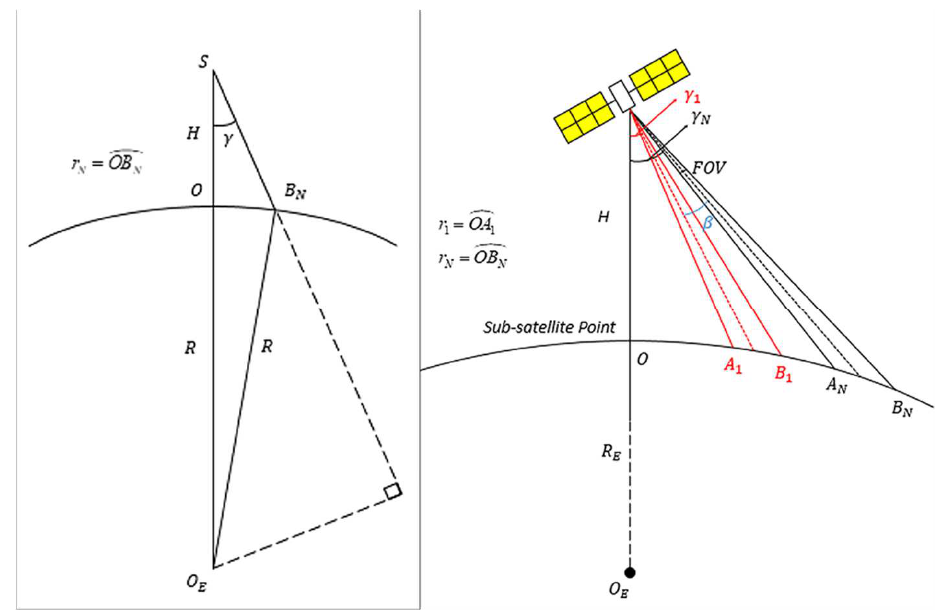
Figure 6. The actual mapping at a large width. As shown in Figure 6, according to the user’s requirements for ground coverage width and ground resolution, the camera parameters such as the image plane size L , field of view angle FOV , focal length f , and satellite parameters such as satellite height H and camera tilt angle γ are determined. Different from traditional imaging with a small field of view, under the condition of ultra-large width of thousand kilometers, the ground needs to